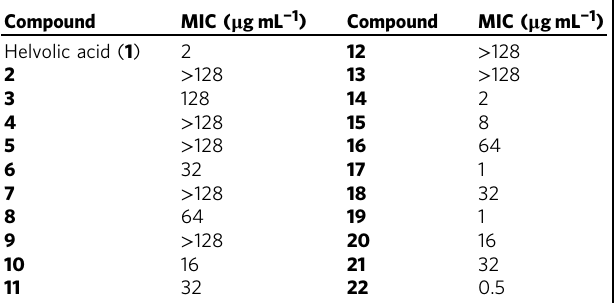
Table 2 Anti- Staphylococcus aureus activity of compounds